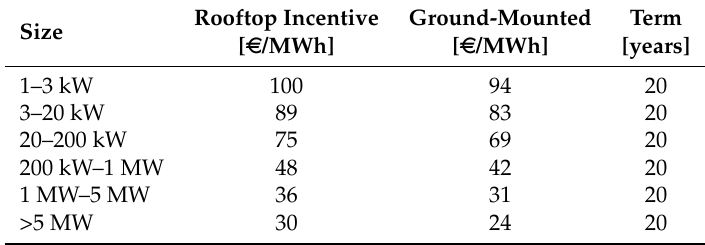
Table 2. Standard self-consumption tariff established in [63].